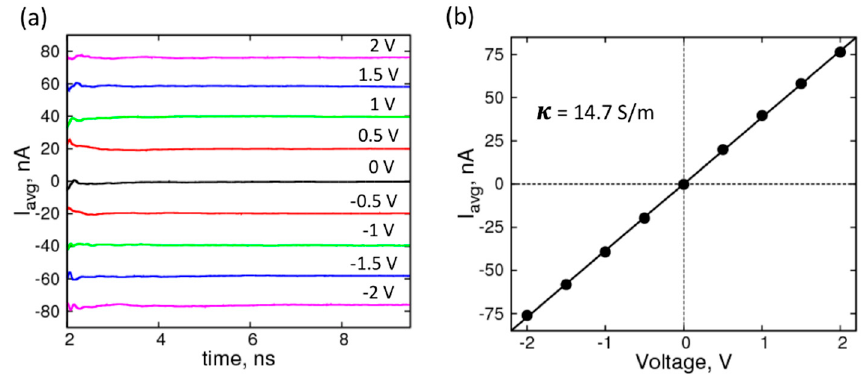
Figure 2. Characterization of the electrolyte (1 M KCl): ( a ) Average current profiles of simulation system with no graphene under forward and reverse biases of ± 2 V (magenta), ± 1.5 V (blue), ± 1 V (green), ± 0.5 V (red), 0 V (black); ( b ) I-V curve for the corresponding system with a straight-line fit yielding a conductivity ( κ ) of 14.7 S/m.